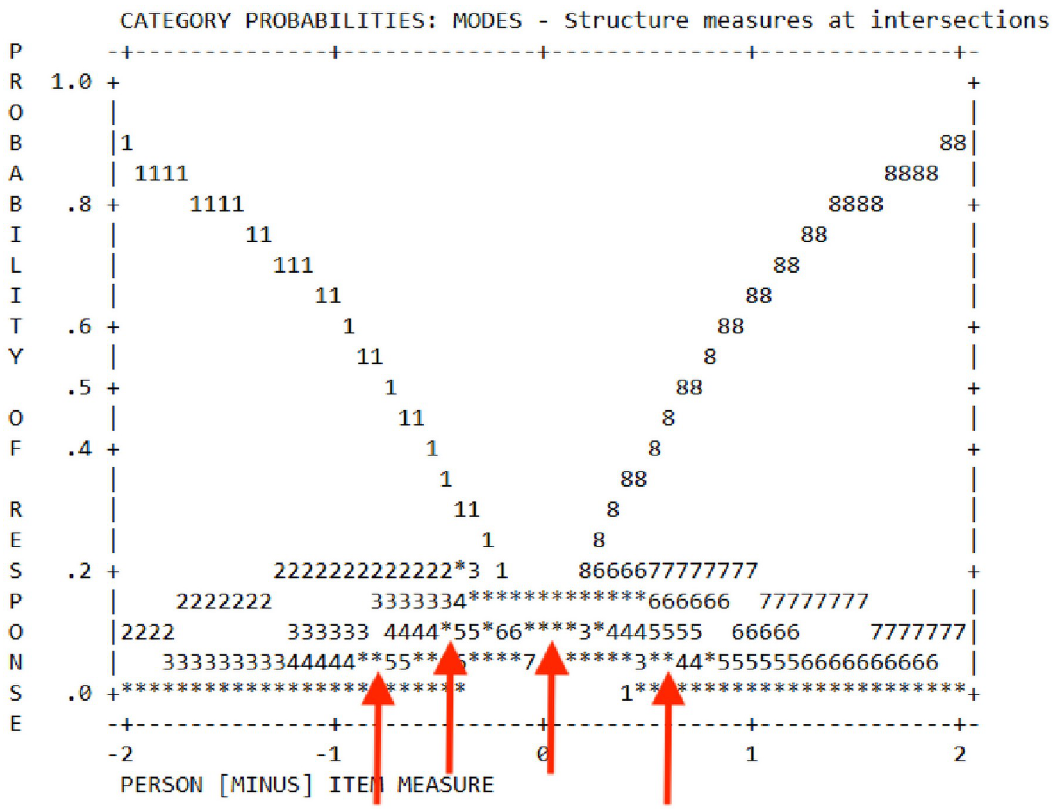
Fig 2. Probability curves for Likert